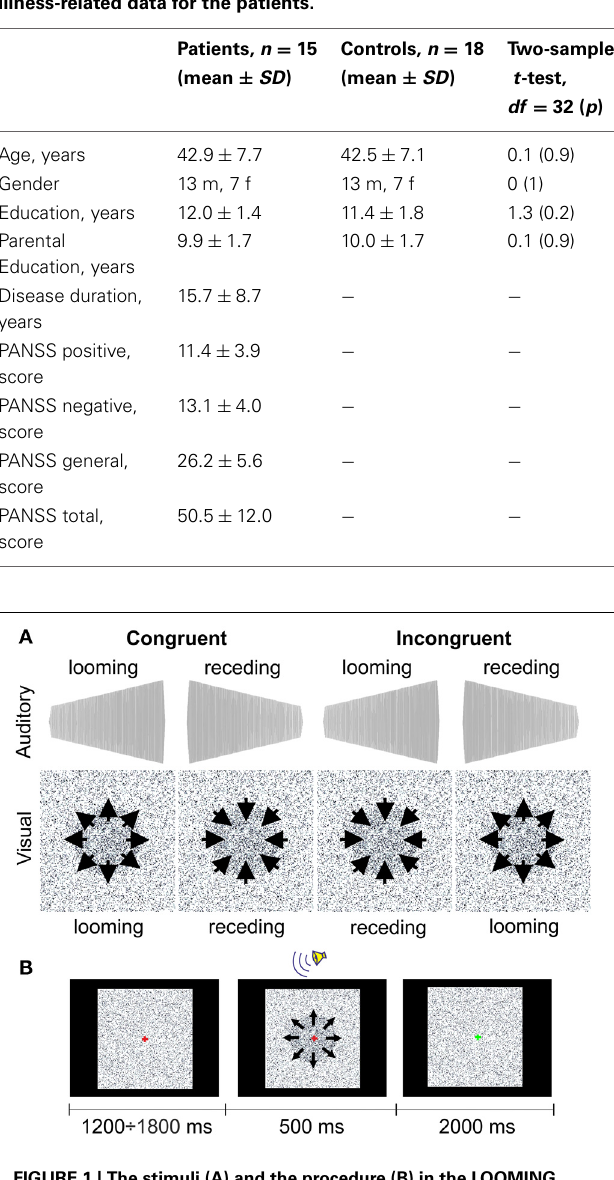
FIGURE 1 | The stimuli (A) and the procedure (B) in the LOOMING paradigm.